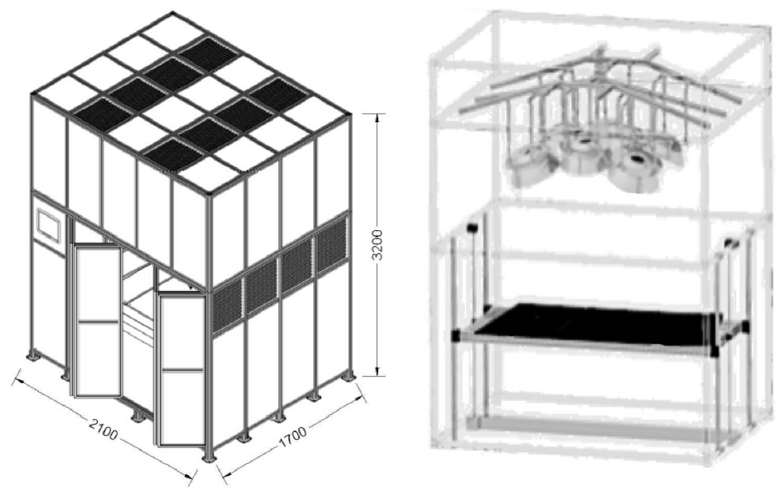
Figure 3. HFSS CAD model: external and internal view.